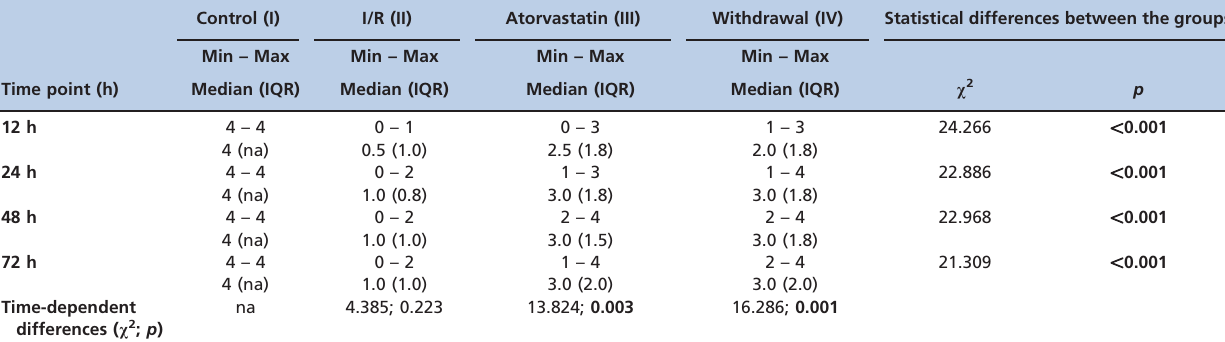
Table 3 - Median Tarlov mobility scores of the experimental groups at selected time points following ischemic injury. Control